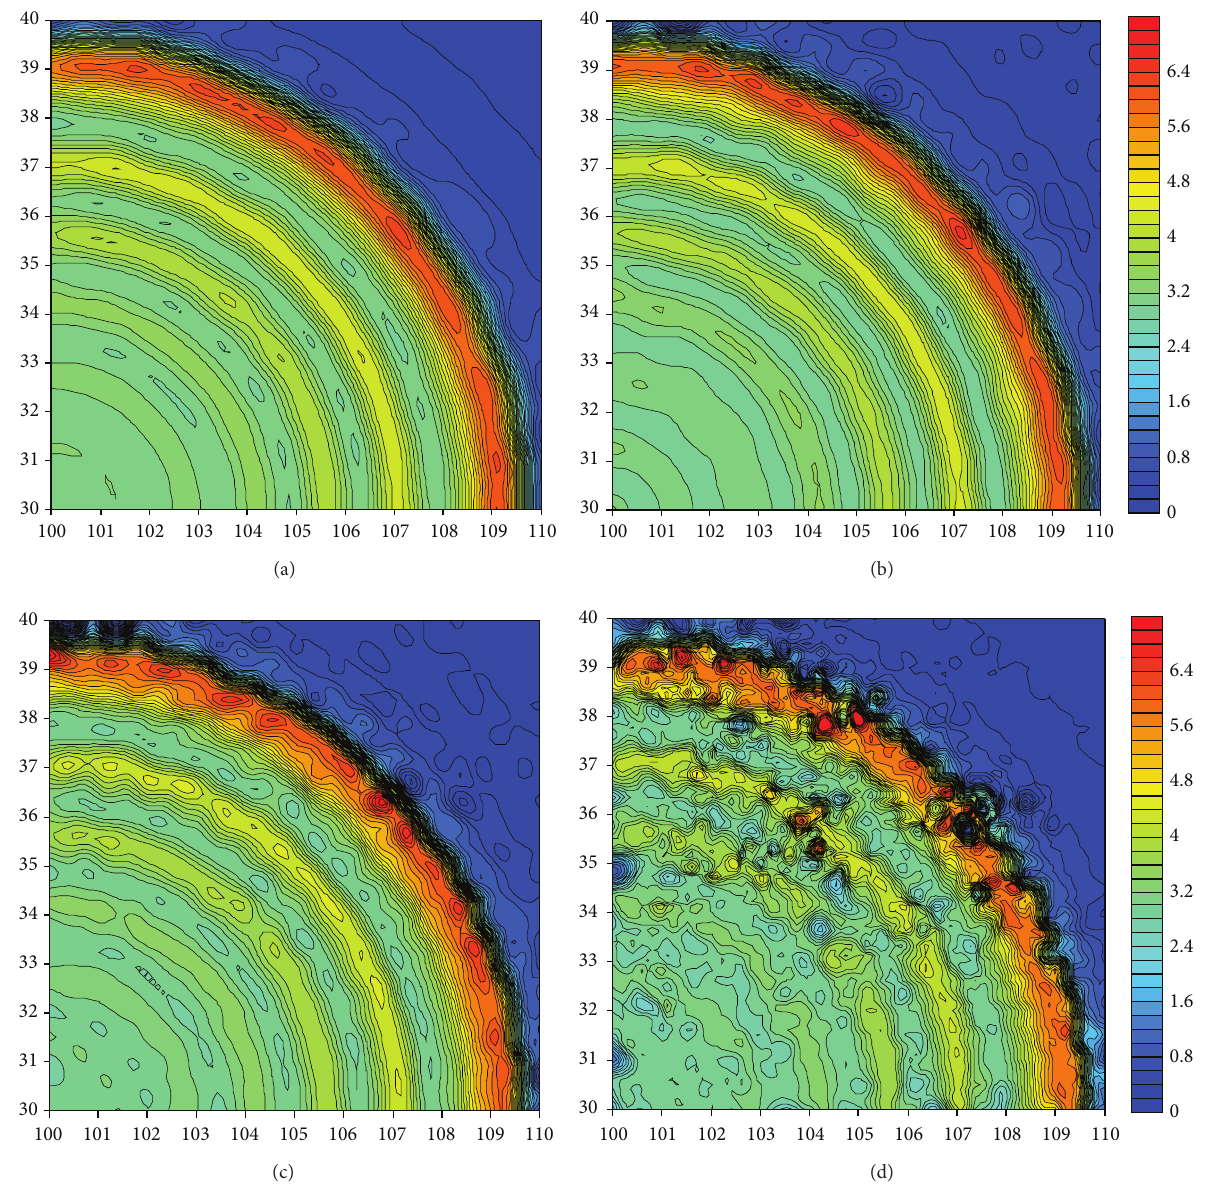
Figure 2: The analyzed temperature fields (unit: ∘ C) using (a) GDF, (b) DF with 𝑎,𝑏 = 1.0 , (c) DF with 𝑎, 𝑏 = 0.5 , and (d) DF with 𝑎, 𝑏 = 0.1